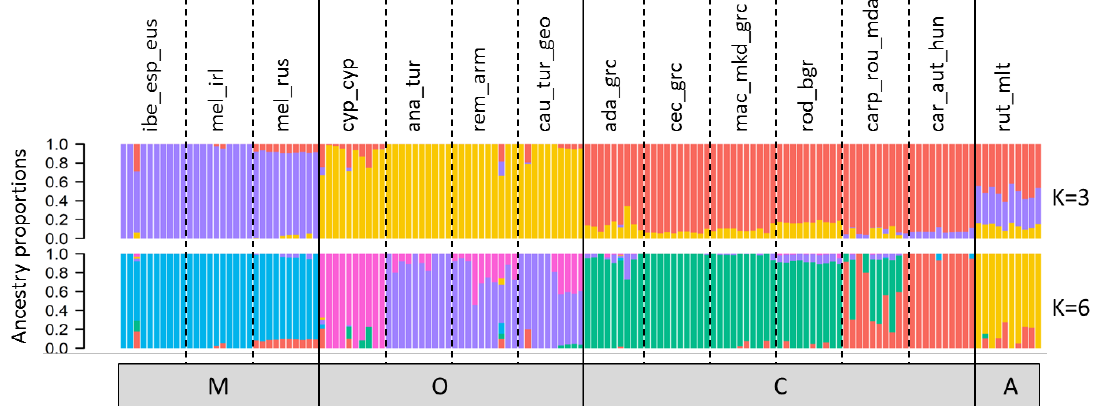
Figure 5. Model-based ancestry as calculated with NGSAdmix for best (K = 3) and second-best (K = 6) number of K ancestral populations. Each individual is represented by a vertical bar and colored according to the proportion of the genome that was derived from one of K clusters. Samples are ordered according to evolutionary lineage and sampling population. M-lineage: ibe_esp_eus = A. m. iberiensis from Spain; mel_irl = A. m. mellifera from Ireland; mel_rus = A. m. mellifera from Russia; C-lineage: car_aut_hun = A. m. carnica from Austria and Hungary; rod_bgr = A. m. rodopica from